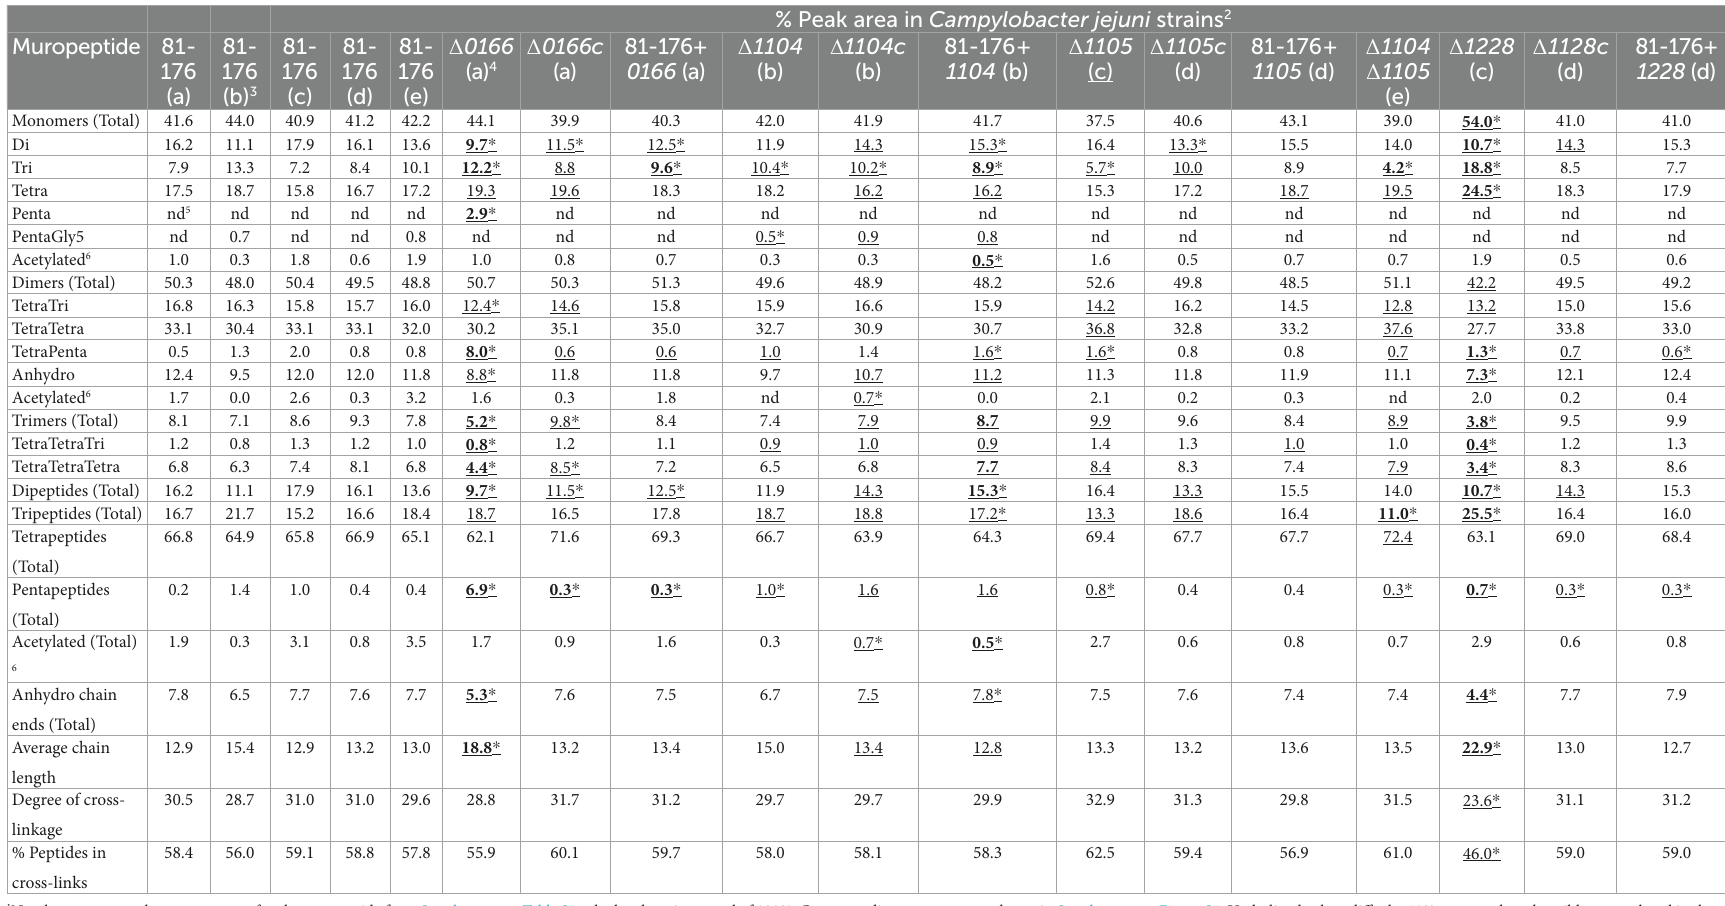
TABLE 2 Summary of the muropeptide composition of C. jejuni wild-type 81-176, ∆ 0166 , ∆ 1104 , ∆ 1105 , ∆ 1104 , ∆ 1105 , and ∆ 1228 mutant strains, complemented strains ∆ 0166 c, ∆ 1104 c, ∆ 1105 c, ∆ 1104 , ∆ 1105 c,